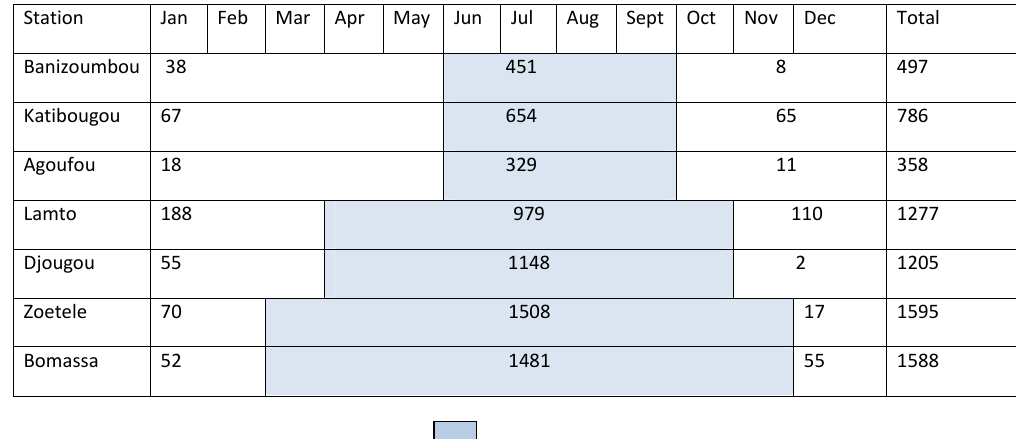
Table 2: Definition of the dry and wet seasons in IDAF stations for the 1998-2007 period. Seasonal accumulated precipitation (mm) and annual precipitation accumulation (mm).